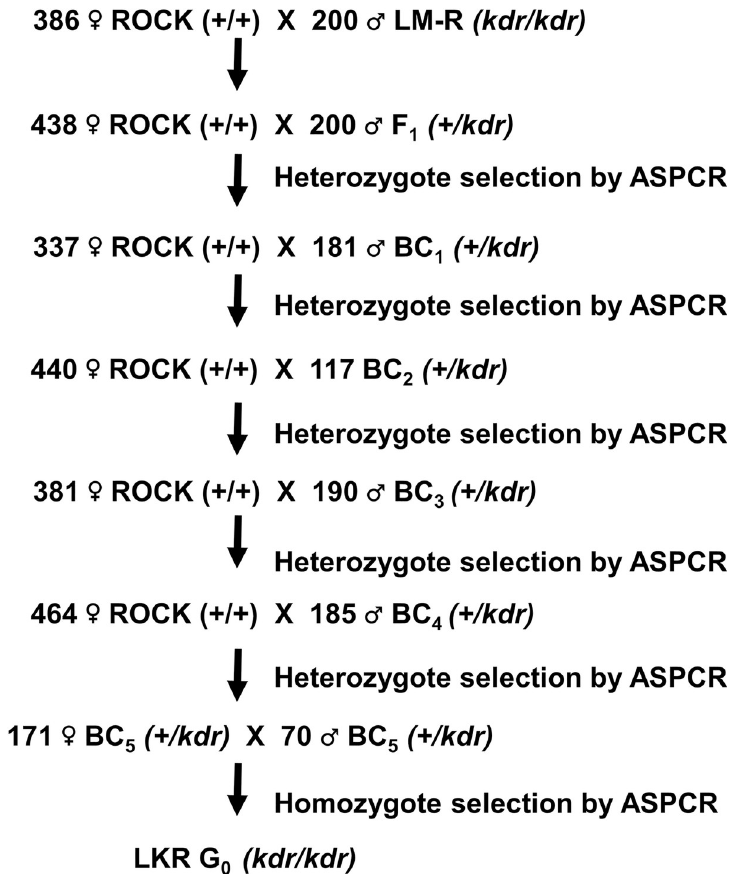
Fig 1. Protocol for the isolation of the congenic strain containing the 410L+1016I+1534C kdr allele introgressed into the genetic background of the ROCK strain. Number of heterozygous (+/ kdr ) males included in each backcross varied depending on the number of females added to the cage (approximately half the number of